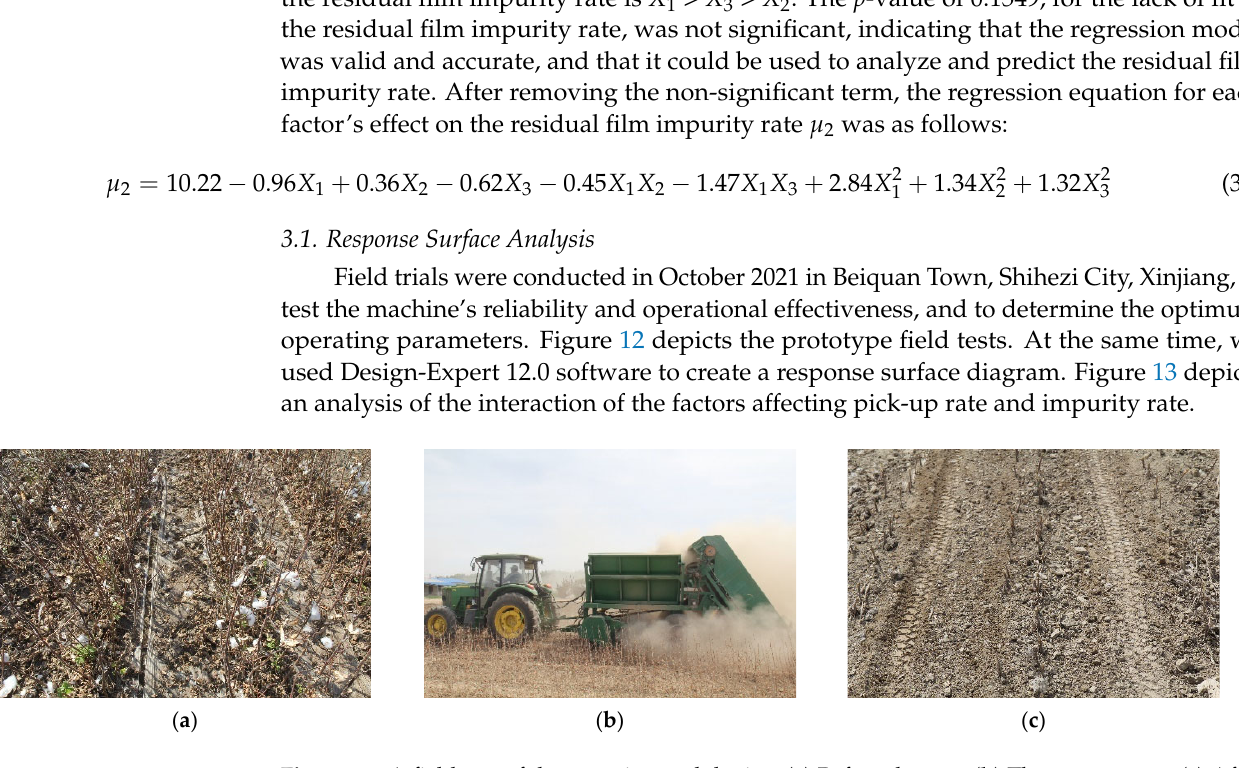
Figure 12. A field test of the experimental device. ( a ) Before the test; ( b ) The test process; ( c ) After the test.